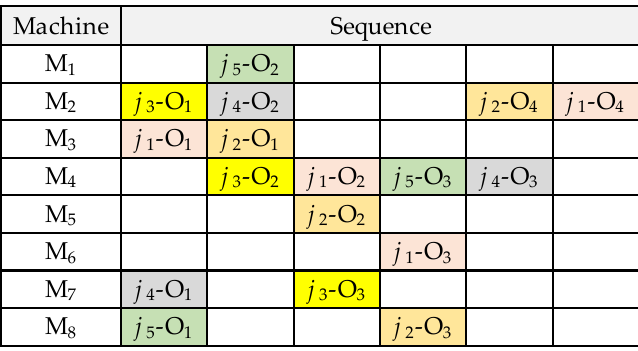
Figure 4. Sequencing of jobs from the beta chromosome.